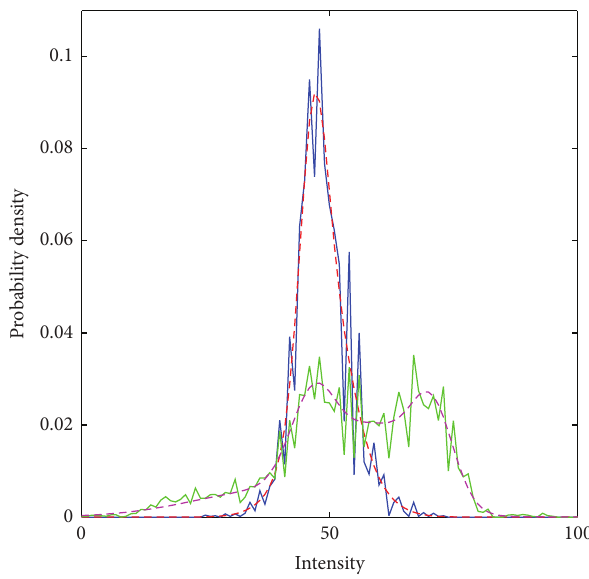
Figure 7: Mixture modeling is shown for inside (narrow curve, red/blue) and outside (broad curve, magenta/green) T1 voxel inten- sities (after histogram equalization). The T1 data is shown with broken lines and the mixture model with solid lines.